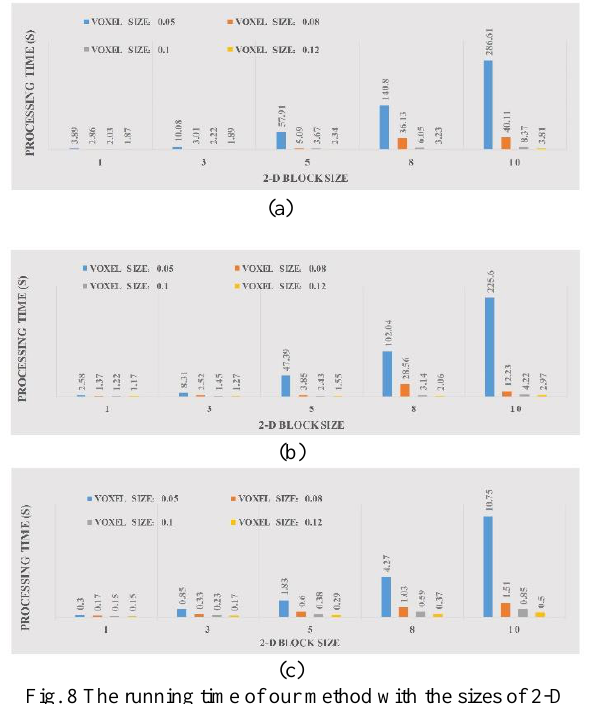
Fig. 8 The running time of our method with the sizes of 2-D block ( Γ b ) and 3-D voxel ( Γ v ): (a) MLSD-1, (b) MLSD-2, and (c) MLSD-3.